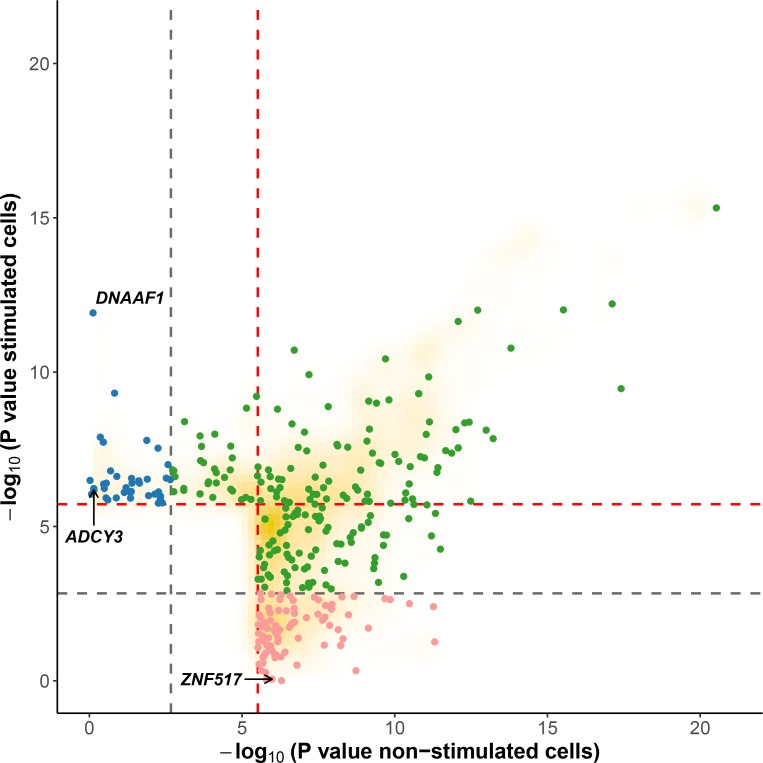
Evidence for cis-eQTL in stimulated versus non-stimulated cells.For each gene, we plotted the SNP with the lowest P value obtained under an additive model in one condition (stimulated or non-stimulated) against the P value obtained under the alternative condition. Red and grey dashed lines correspond to the 0.01 and to the 0.5 FDR to classify response eQTL (reQTL). Green dots are general cis-eQTL (found in both conditions). Blue dots are reQTL specific to cells stimulated with M. leprae sonicate while pink dots are reQTL specific to untreated cells. For this figure, reQTL are variants that exhibit a significant P value for genotype-phenotype association in one condition at an FDR of 0.01 and not in the other condition at an FDR of 0.5 (without taking the entire 200-kb tested regions per gene into account). The orange cloud corresponds to all the variants detected as being cis-eQTL at an FDR of 0.01.